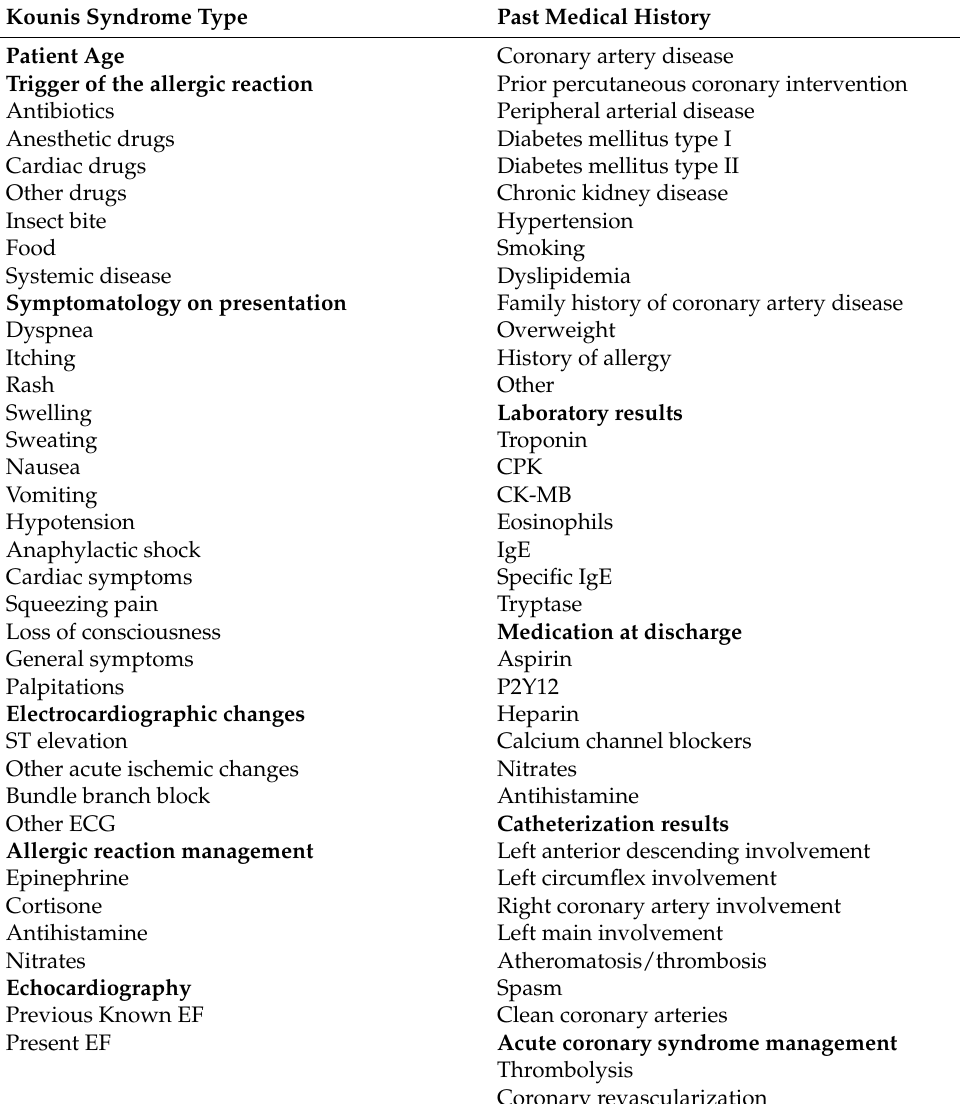
Table 1. List of extracted